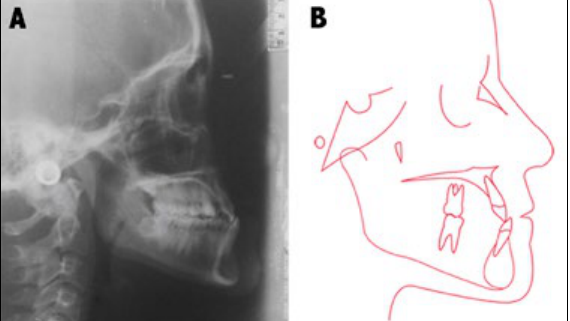
Figure 4. Pretreatment lateral cephalogram (A) and cephalometric tracing